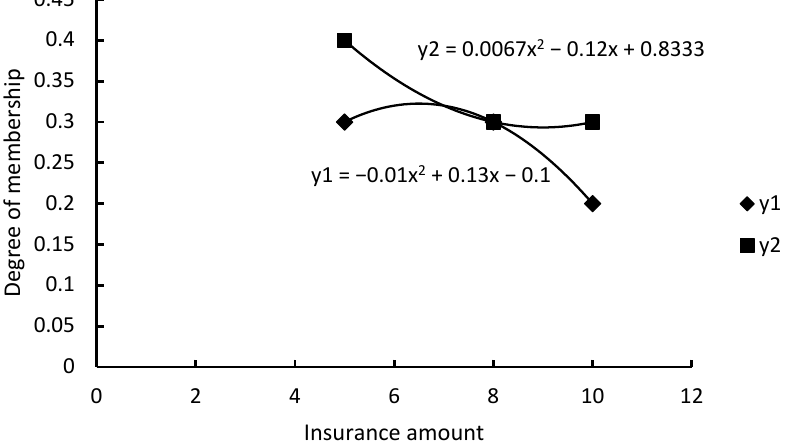
Figure A21. Single factor evaluation for the index of insurance amount (5–10 (inclusive) ten thou- sand yuan).